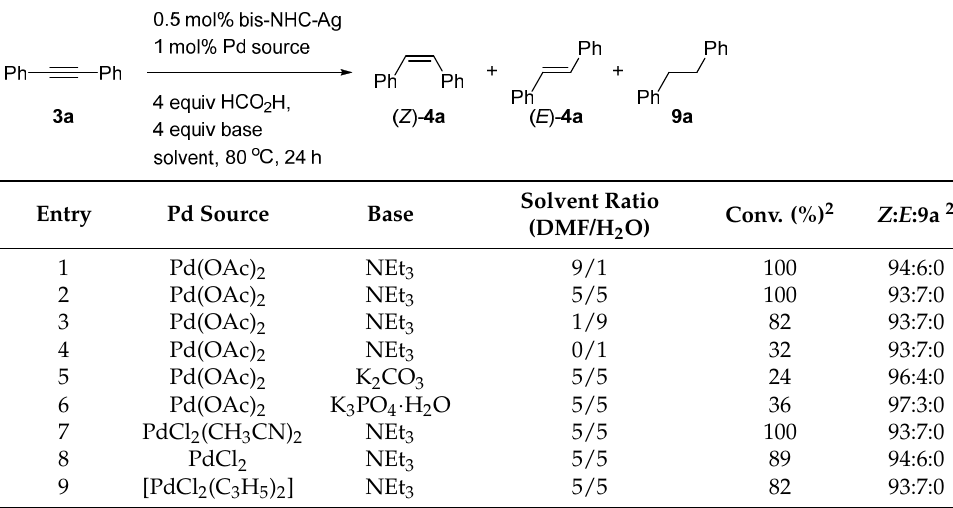
Table 3. Bis -NHC–Ag / Pd(OAc) 2 catalytic system catalyzed transfer hydrogenation 1 .